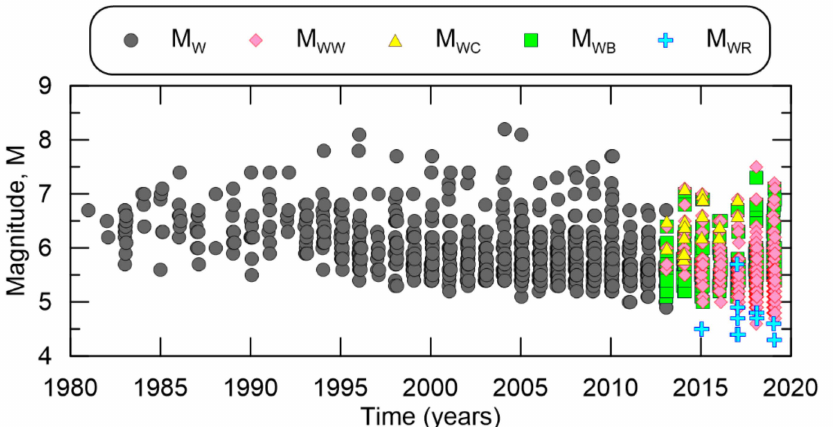
Figure 2. Moment magnitude types from NEIC and timeframes when they are valid in the Indone- sian catalog.